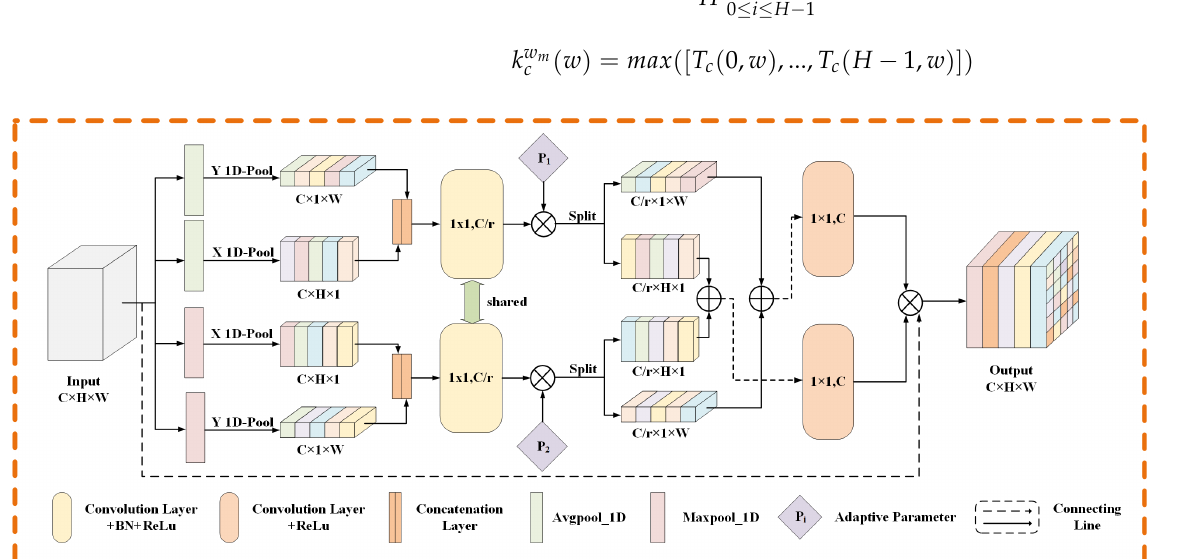
Figure 3. Details of the designed adaptive coordinate attention module. The 1 × 1 and numbers (C, C/r) in the Convolution block correspond to the size of the convolution kernel and the number of output channels, respectively. Additional maxpooling coding is used to elevate coding differences between capillaries and background. Two learnable parameter weights are used to adaptively combine the two coding